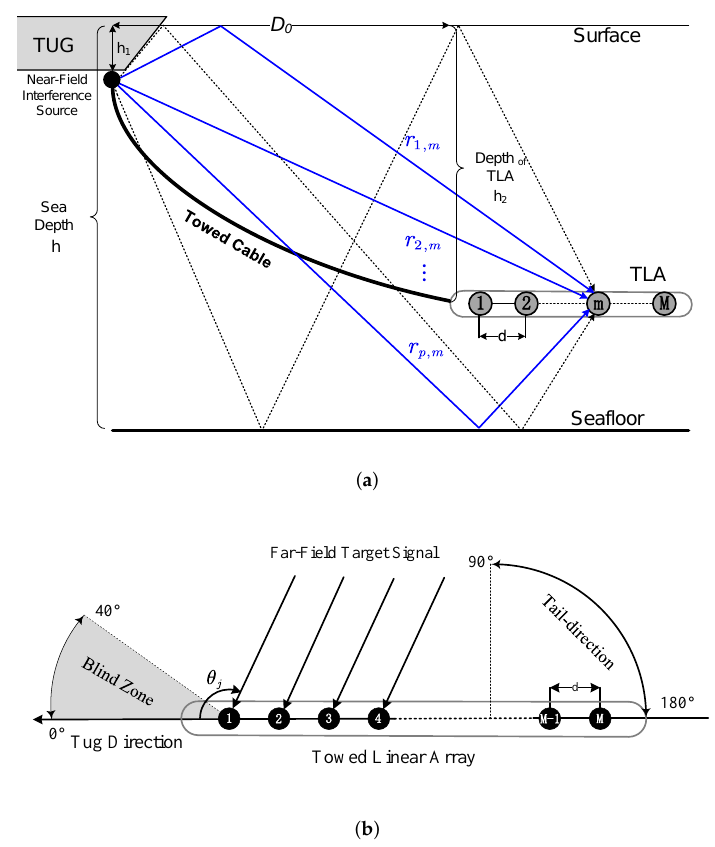
Figure 1. A towed linear array impinged by far-field target and near-field interference source signals. ( a ) The multi-path propagation of near-field interference source. ( b ) Mapping of the far-field target signal in the horizontal